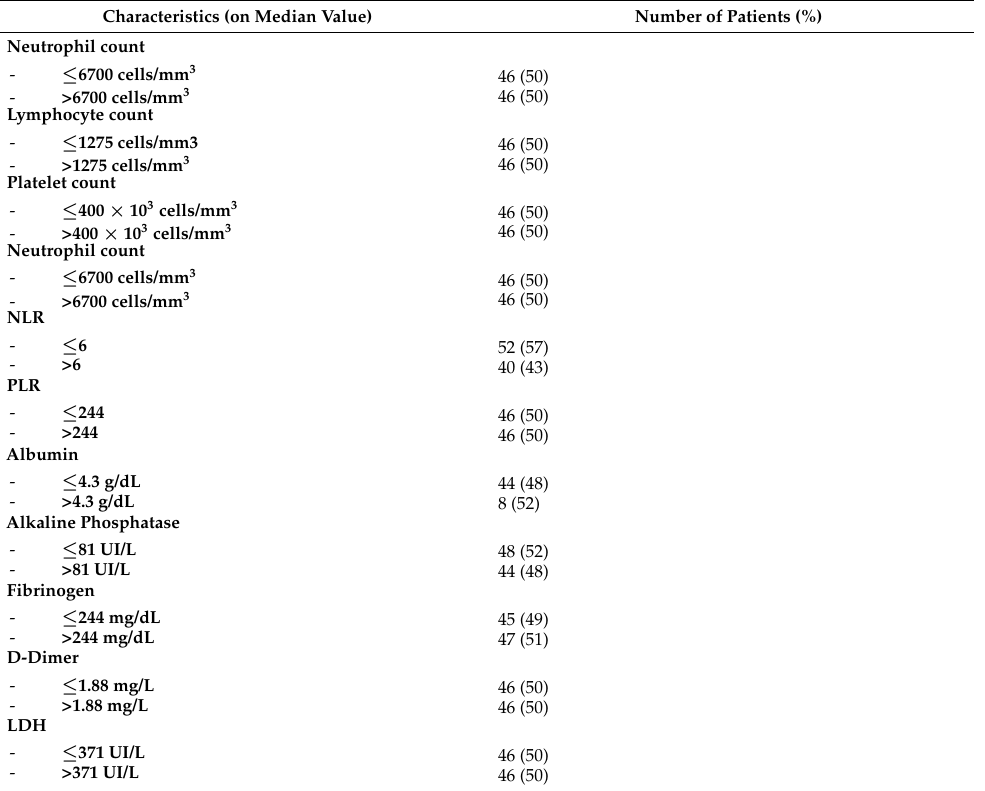
Table 2. Basal characteristics of patients, laboratory cut-off. Patients were separated into two groups on the basis of median value. Each parameter was analyzed on the median value and then reported in terms of number and percentage for each variable. Characteristics (on Median Value) Number of Patients